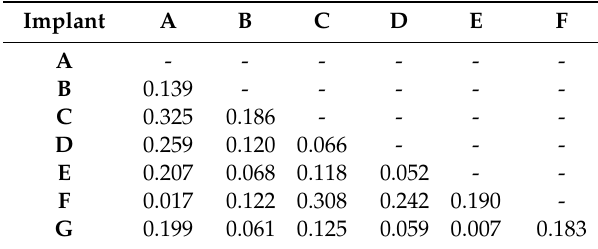
Table 4. The values of near-infrared (NIR)-test Tukey.